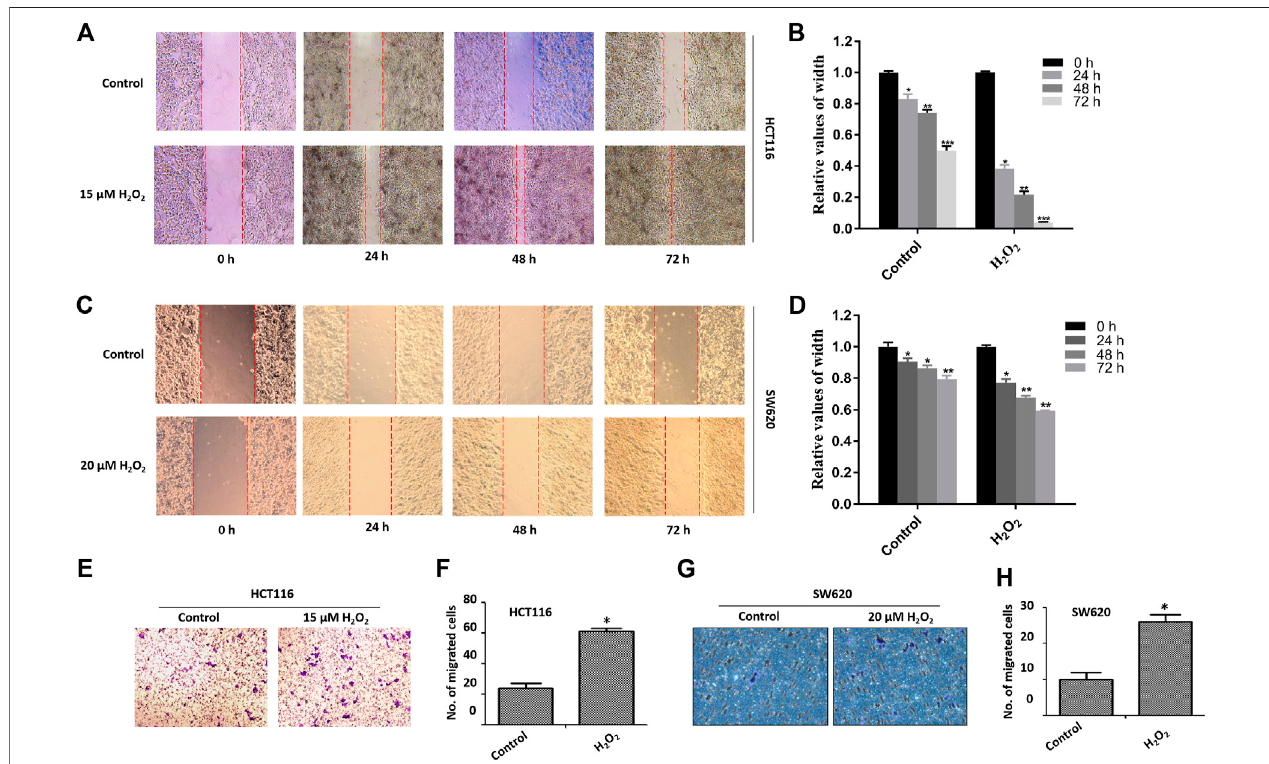
FIGURE 2| Effects ofH 2 O 2 on CRC cell migration. The HCT116 cells (A) and SW620 cells (C) were treated with H 2 O 2 for different time, and the cell migration was determined by the wound healing assay. The width of wound area in HCT116 cells (B) and SW620 cells (D) was quantitatively analyzed. The migration of HCT116 cells (E) and SW620 (F) cells treated with or without H 2 O 2 was measured by the modi fi ed Boyden chamber assays. Quantitative results of the numbers of migrated cells in HCT116 cells (G) and SW620 cells (H) . The experiments were performed in triplicate ( n (cid:1) 3). Error bars represent mean ± S.D. p < 0.05 was considered to be statistically signi fi cant. * p < 0.05; ** p < 0.01.